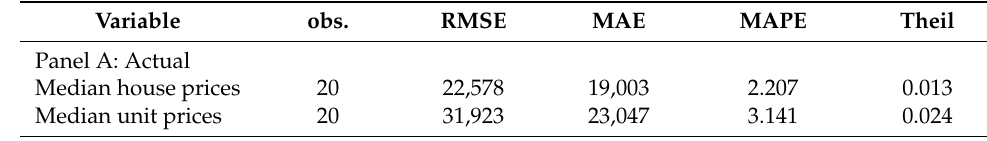
Table 3. Out-of-sample testing, Q1 2014–Q4